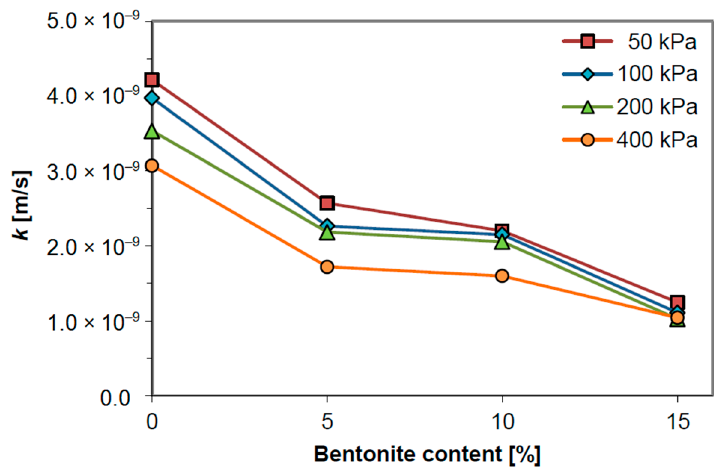
Figure 9. Hydraulic conductivity for bentonite content of materials tested at hydraulic gradient i = 32.